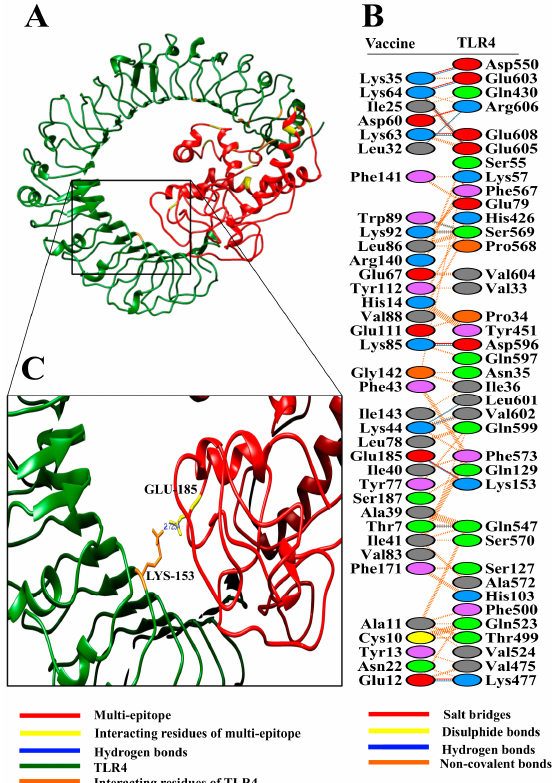
Figure 4. ( A ) Figure obtained after molecular docking showing vaccine construct-TLR4 docked complex. Vaccine construct is shown in red color while TLR4 is shown in green color; ( B ) interacting residues between docked vaccine (chain A) and TLR4 (chain B); ( C ) few prominent hydrogen bonds within vaccine-TLR4 complex are focused.